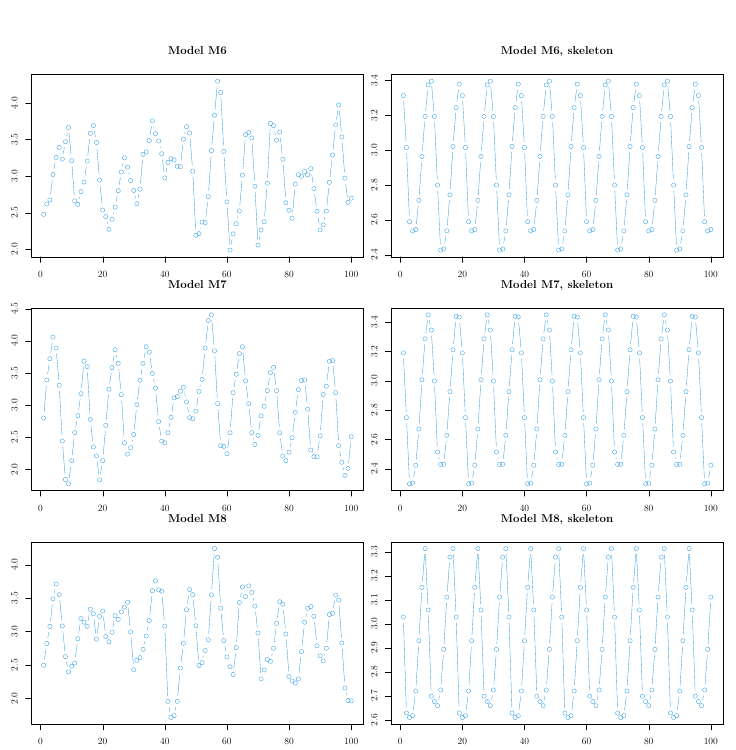
Figure 19 – Time plot of the simulated time series and their skeletons for TARMA models M6 –